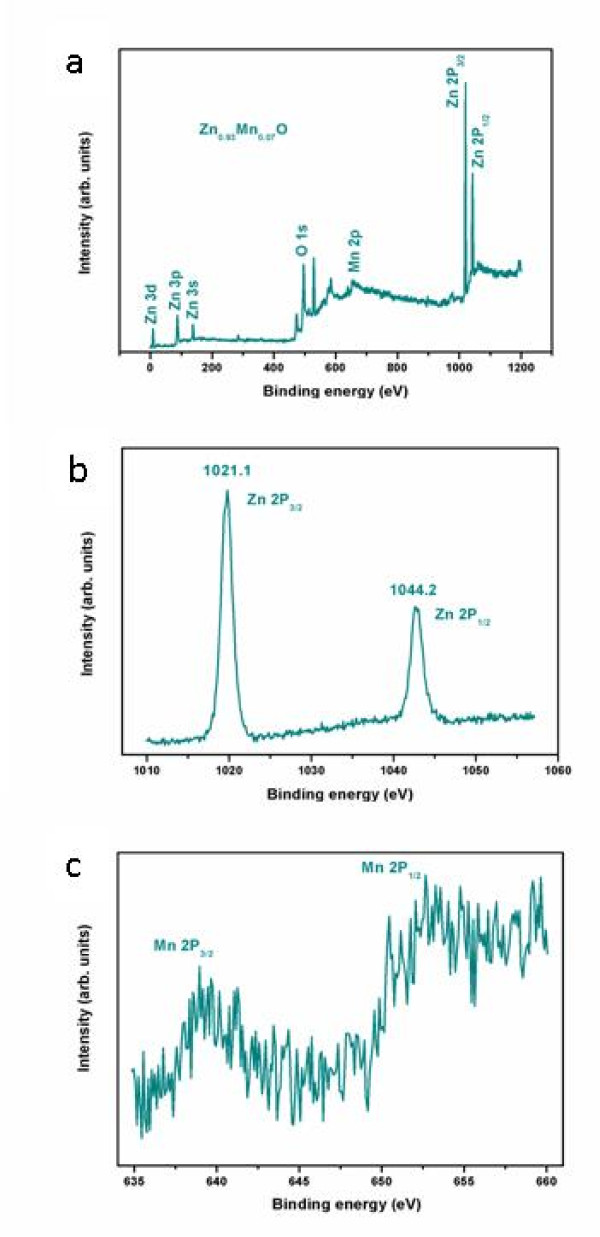
XPS for Zn0.93Mn0.07O HMSs. The elements of Zn, Mn, O, and adventitious C (a). The high-resolution XPS spectra of Zn (b) and Mn (c) species.